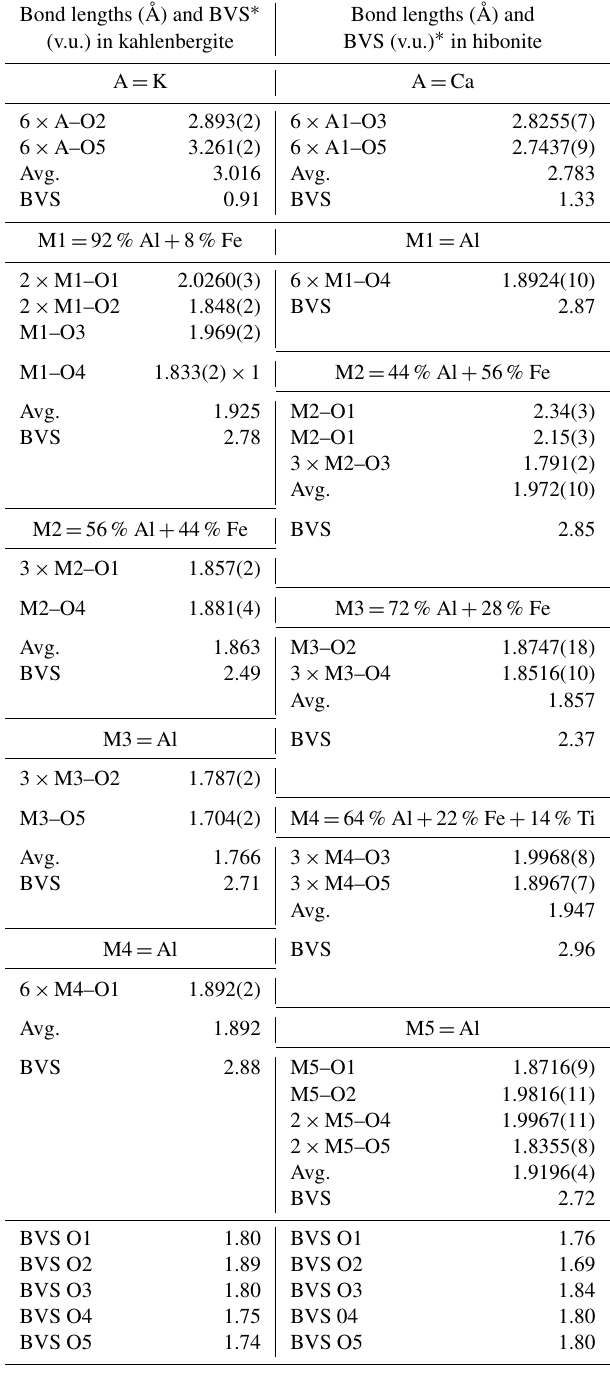
Table 6. Selected bond distances (Å), average bond lengths (Avg.) and bond valence sums (BVSs) up to 3.3Å in a kahlenbergite struc-